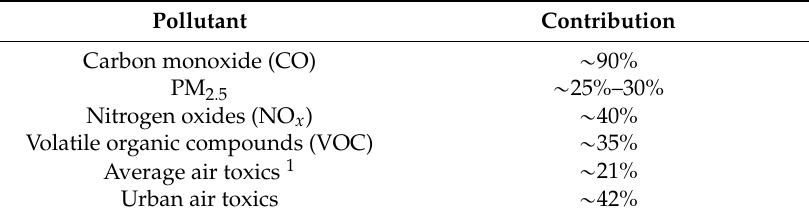
Table 1. The estimated contribution of motor vehicle emissions to ambient levels of air pollutants in developed countries (based on [46]).